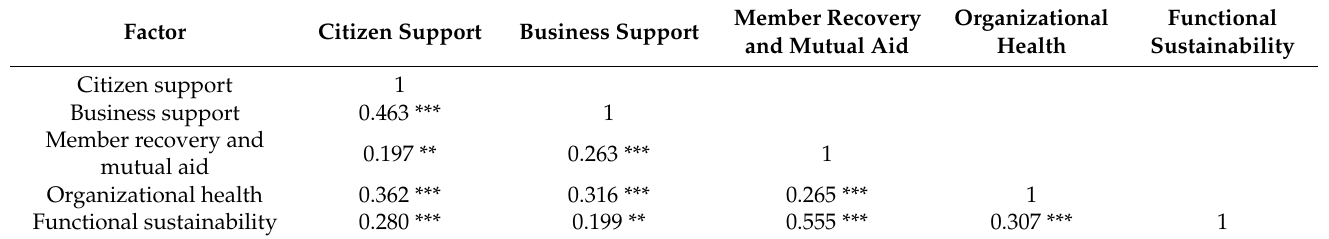
Table 4. Correlations among the five factors of total sample